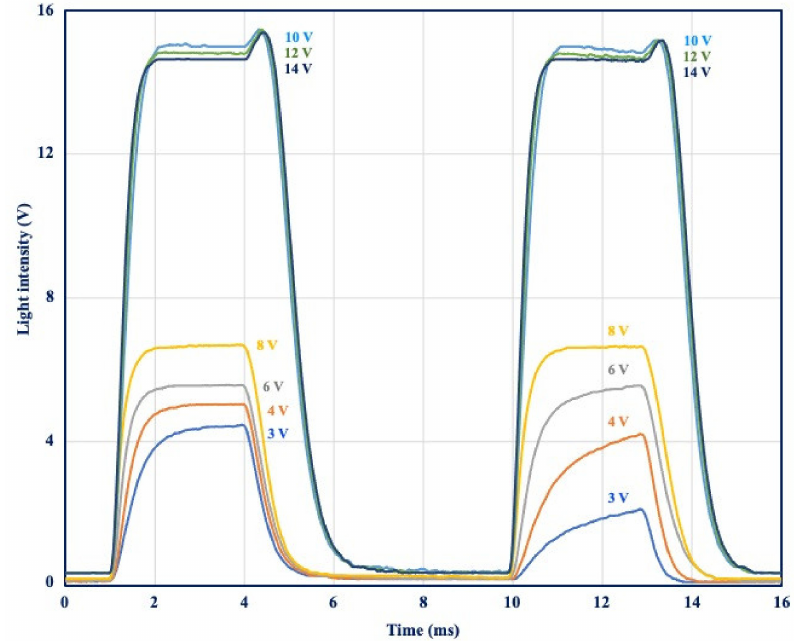
Figure 10. Applied pulse voltage dependence of light throughput of the expectedly slightly-twisted stacked SSD-LC panel. Applied pulse voltage is a bipolar pulse with a 3 ms duration with a 5 ms zero voltage